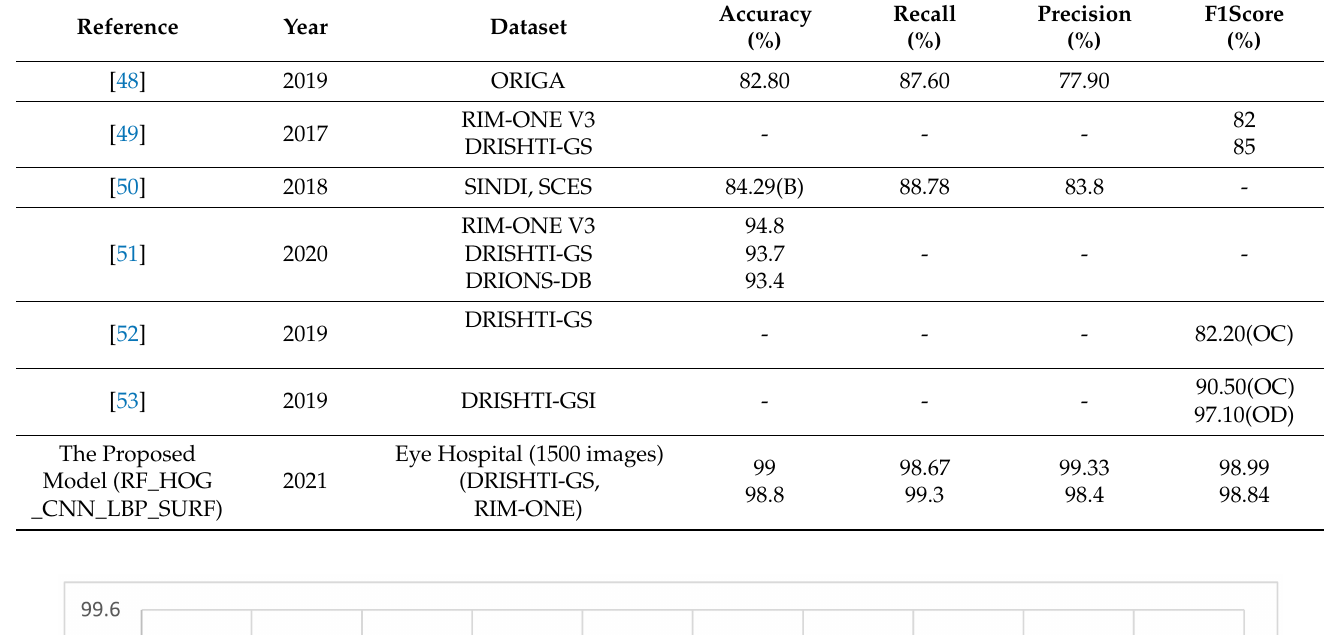
Table 6. Comparative Analysis with State-of-the-Art Techniques.